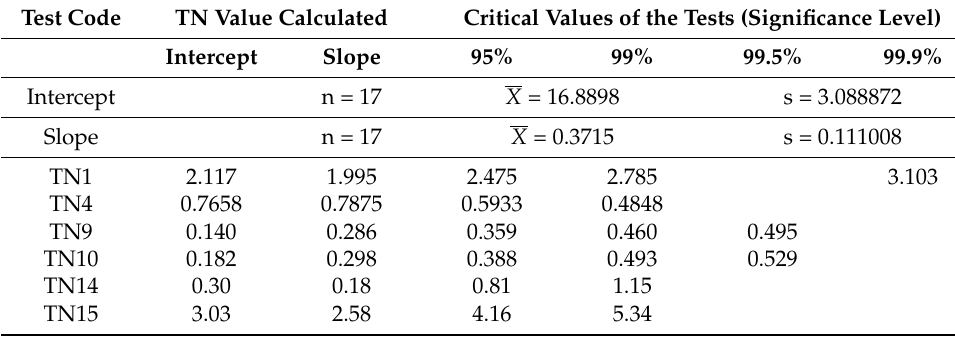
Table 4. Results of the discordance tests of the equations for a hot-humid